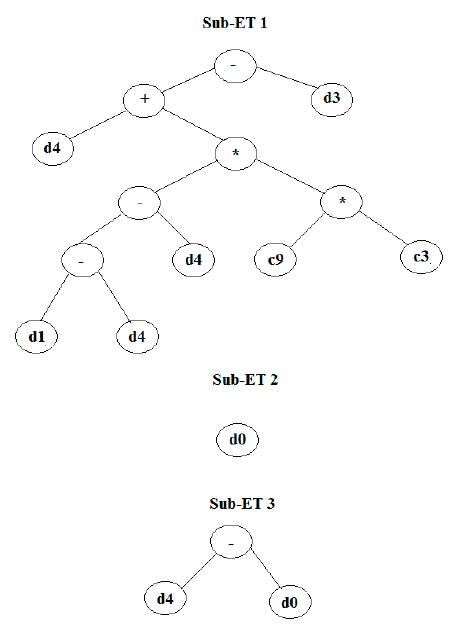
Figure A1. 3 genes (sub-expression tree diagram) linked together by addition function.